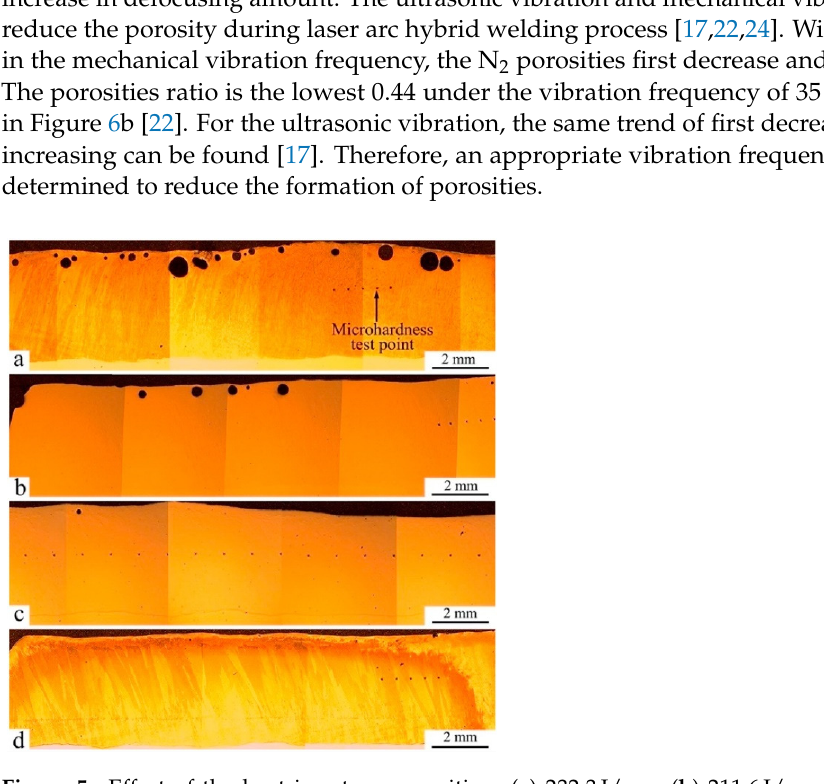
Figure 5. Effect of the heat input on porosities. ( a ) 232.3 J/mm ( b ) 211.6 J/mm ( c ) 205.2 J/mm ( d ) 180.2 J/mm. Reprinted with permission from ref. [21]. Copyright 2021, Elsevier.